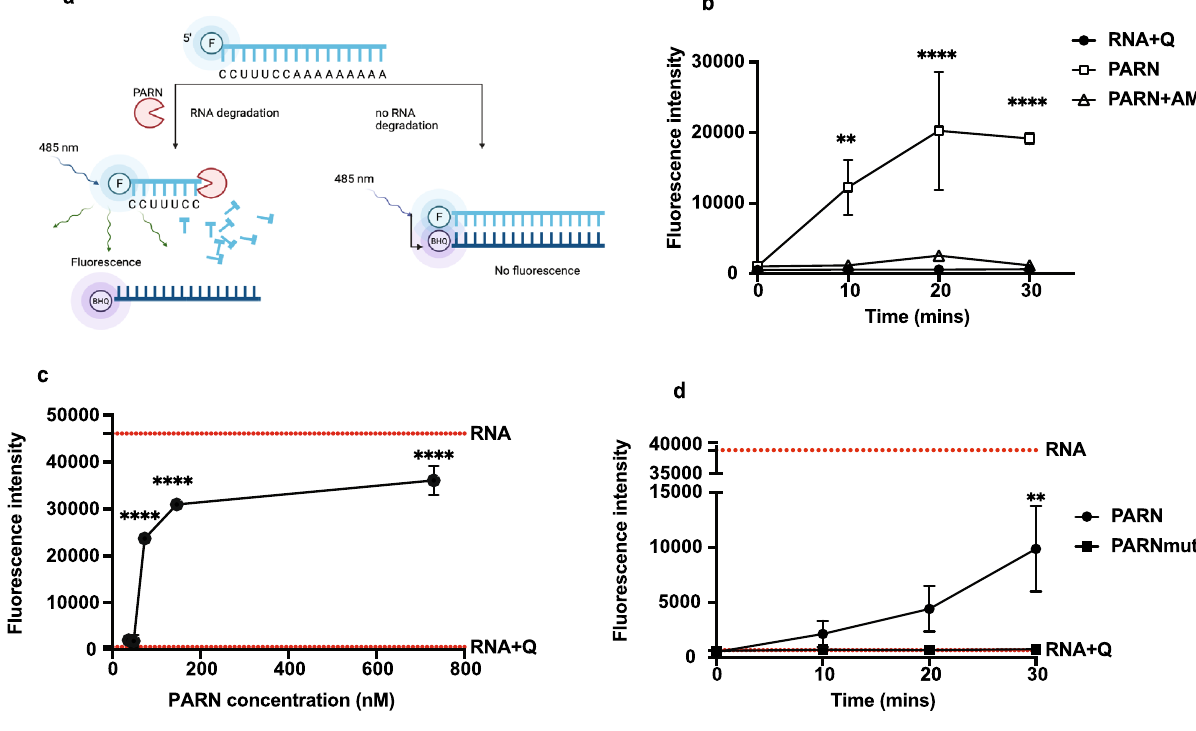
Figure 3. Developing a fluorescence assay for PARN inhibition. ( a ) Cartoon depicting the inhibition fluorescence assay. Schematic diagram of the fluorescence-based deadenylase assay. The assay is based on a 5 ′ FAM-labelled RNA oligonucleotide substrate. After incubation of the substrate in the presence of PARN 1-430 , the reaction is stopped and a 3 ′ BHQ-labelled DNA oligonucleotide probe complementary to the RNA substrate is added. The fluorescence of intact substrate is quenched upon probe hybridization because of the proximity of the BHQ fluorophore. In contrast, the BHQ-labelled probe cannot hybridize to the FAM-labelled reaction product allowing detection of FAM fluorescence 37 . ( b ) PARN 1-430 inhibition assay with fluorescence as a readout with time course for PARN 1-430 treatment (73 nM), PARN 1-430 inhibition with 2.5 mM AMP, and no-enzyme control. 2-way ANOVA, multiple comparisons test, average ± SD, n = 3 replicates. *P < 0.05, **P < 0.005, ***P < 0.001, ****P < 0.0001, n.s. was not indicated. ( c ) Dose–response curve of PARN 1-430 enzymatic activity using different PARN 1-430 concentrations (36.5–730 nM). Dotted-line represents RNA and RNA + Quencher data. One-way ANOVA, multiple comparisons test, average ± SD, n ≥ 3 replicates. *P < 0.05, **P < 0.005, ***P < 0.001, ****P < 0.0001, n.s. was not indicated. ( d ) PARN 1-430 and PARNmut enzymatic activity measured at different time points. PARN showed an increase in activity versus time while PARNmut showed no activity up to 30 min incubation. Dotted-line represents RNA and RNA + Quencher data. 2-way ANOVA, multiple comparisons test, average ± SD, n = 3 replicates. *P < 0.05, **P < 0.005, ***P < 0.001, ****P < 0.0001, n.s. was not